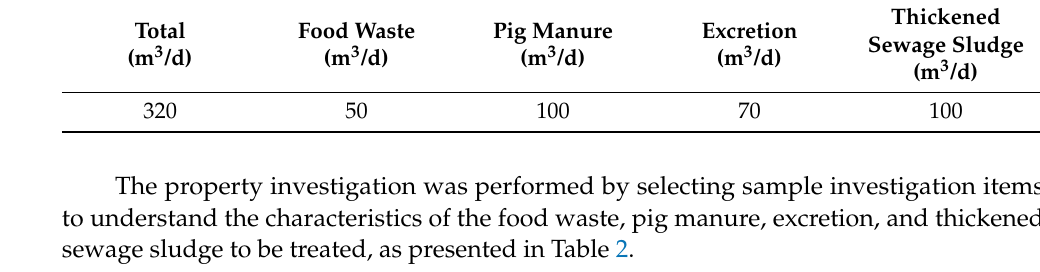
Table 1. Organic waste to be treated.